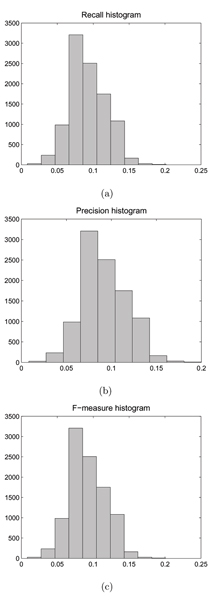
Random networks. Histograms of recall (a), precision (b) and F-measures (c) for 104 random networks containing 120 links (equal to the number of parent-child relationships in the true model).